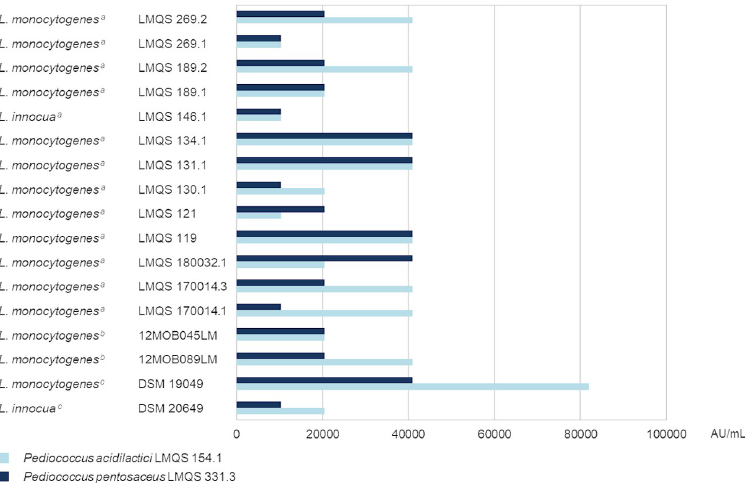
Fig 3. Sensitivity if different Listeria spp. strains to concentrated bacteriocins in arbitrary units (AU) per mL. Origin of Listeria spp. test strains: � : Institute for Food Quality and Food Safety (LMQS), University of Veterinary Medicine Hannover, Foundation, Hannover, Germany; †: European Reference Laboratory for Listeria monocytogenes ; ‡ : Leibniz Institute DSMZ-German Collection of Microorganisms and Cell Cultures, Brunswick, Germany.